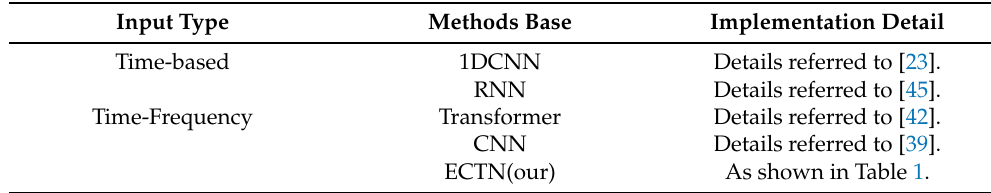
Table 2. The comparison methods. Input Type Methods Base Implementation Detail